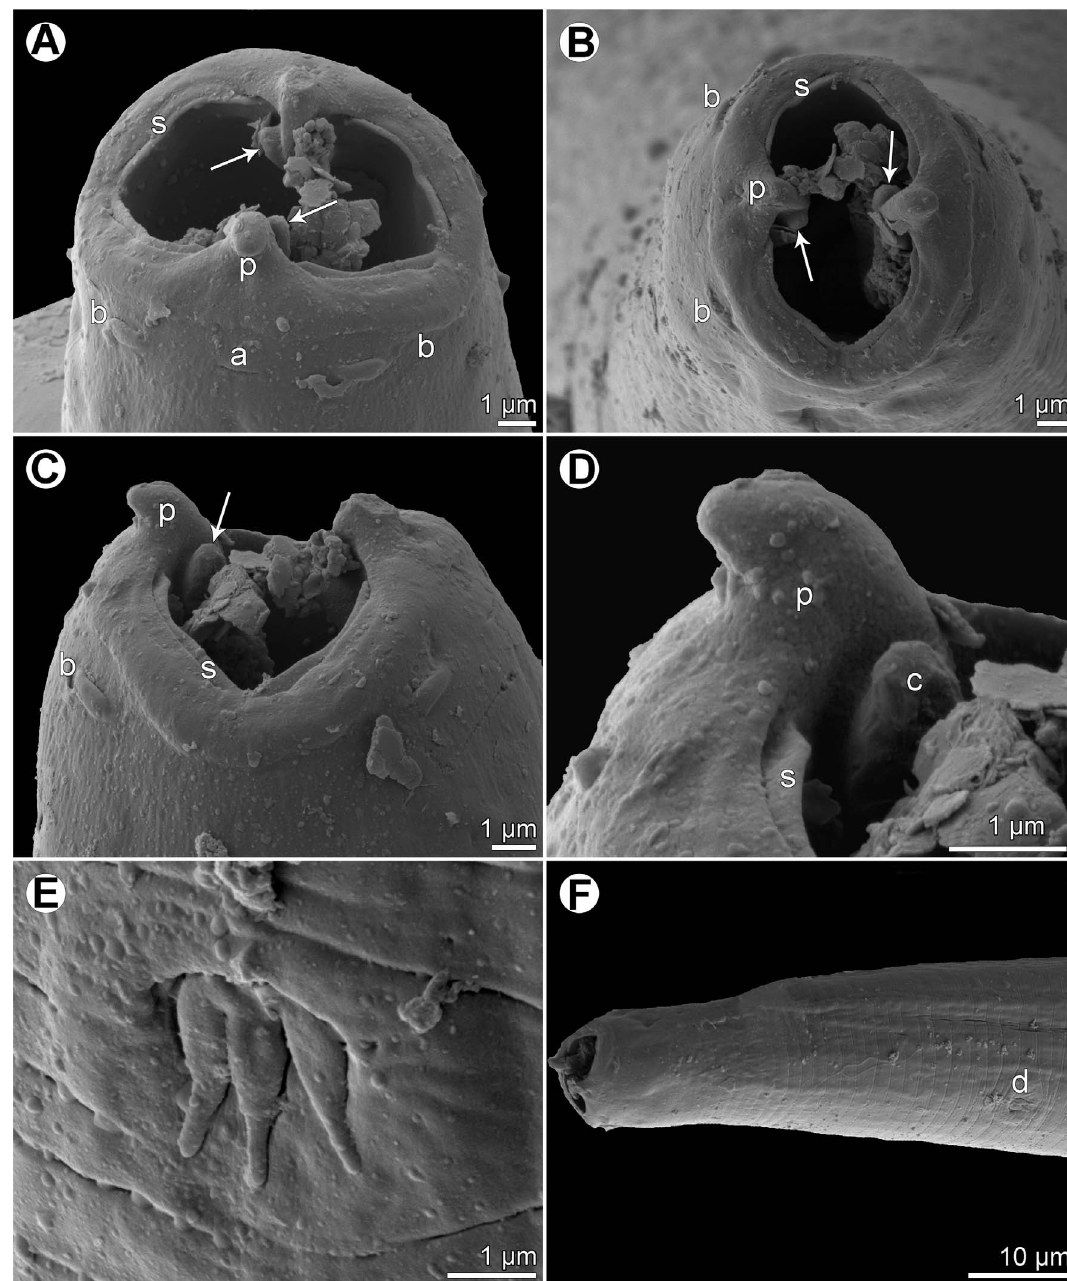
Figure 8. Ascarophisnema tridentatum Moravec et Justine, 2010 from Gymnocephalus grandoculis , scanning electron micrographs of female. (A, B) Cephalic end, lateral and apical views, respectively (arrows indicate tooth-like pseudolabial extensions); (C) cephalic end, dorsoventral view (arrow indicates tooth-like pseudolabial extension); (D) enlarged region of pseudolabium, dorsoventral view; (E) deirid; (F) anterior end of body, sublateral view. (a) Amphid; (b) cephalic papilla; (d) deirid; (p) pseudolabium; (s)